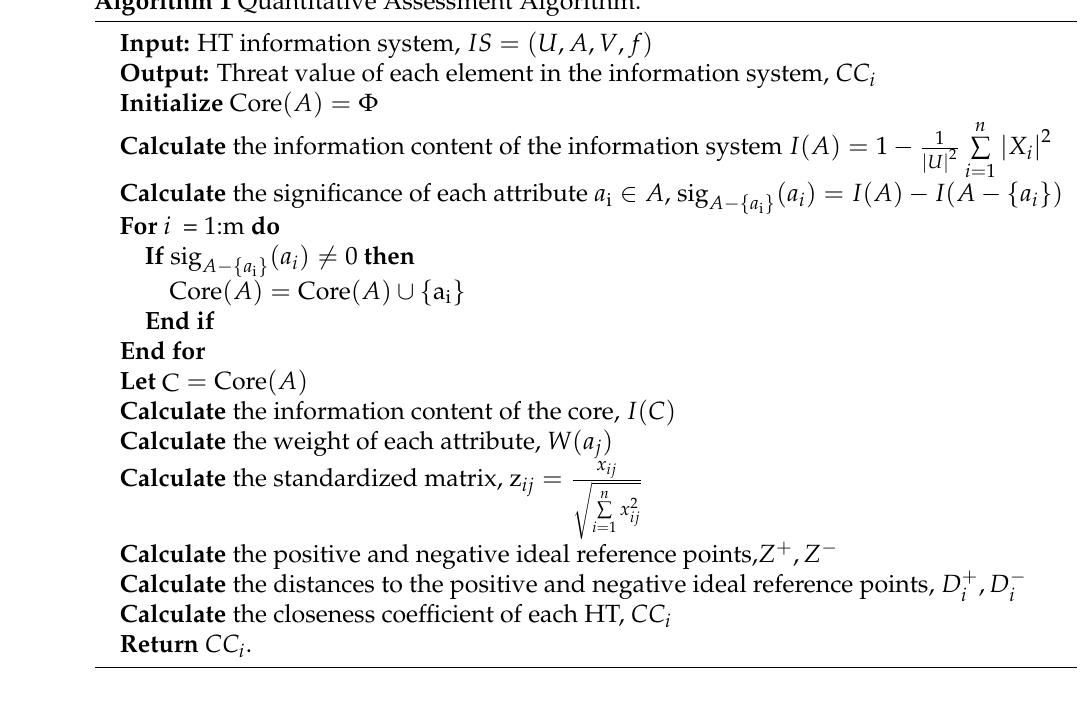
Algorithm 1 Quantitative Assessment